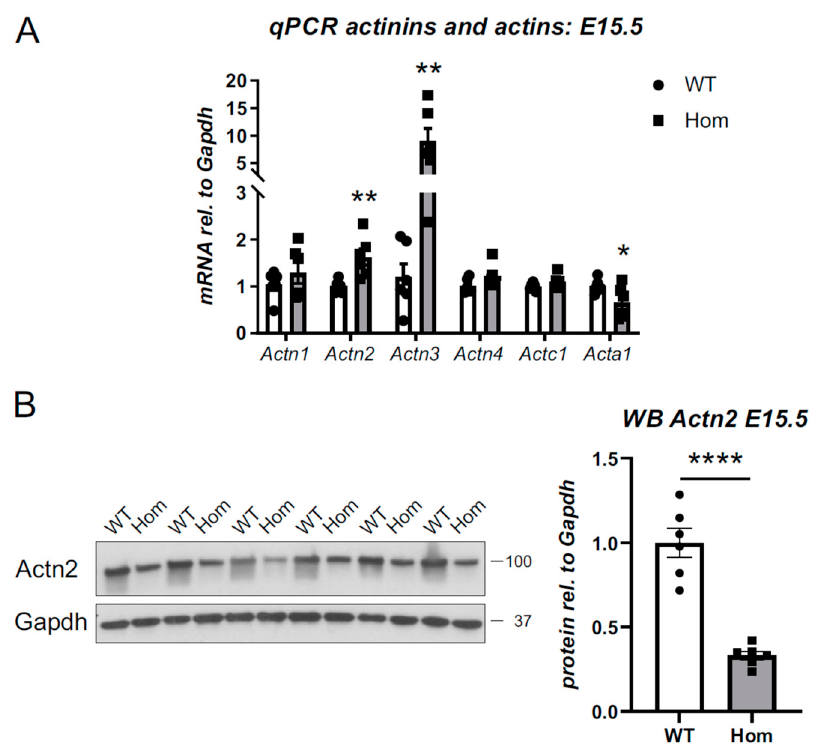
Figure 7. Actn2 destablisation at the protein level in Hom E15.5 hearts. ( A ) Targeted assessment of transcriptional changes by qPCR in WT and Hom E15.5 for actinins (Actn1-Actn4) and actins (cardiac actin Actc1 and skeletal muscle actin Acta1). All measurements are normalised to Gapdh. Significant upregulation of Actn2 and Actn3 as well as downregulation of Acta1 are observed in the hearts of Hom mice (Student’s t -test, n = 6 per group, * p < 0.05, ** p < 0.01)). ( B ) Reduced protein levels of alpha-actinin 2 in Hom E15.5 hearts. Left—Western blot for alpha-actinin 2 (Actn2) and Gapdh ( n = 6 per group); position of marker bands indicated (molecular weight in kD). Right—Quantification indicates reduction of Actn2 protein levels in Hom E15.5 hearts (Student’s t -test, **** p < 0.0001).